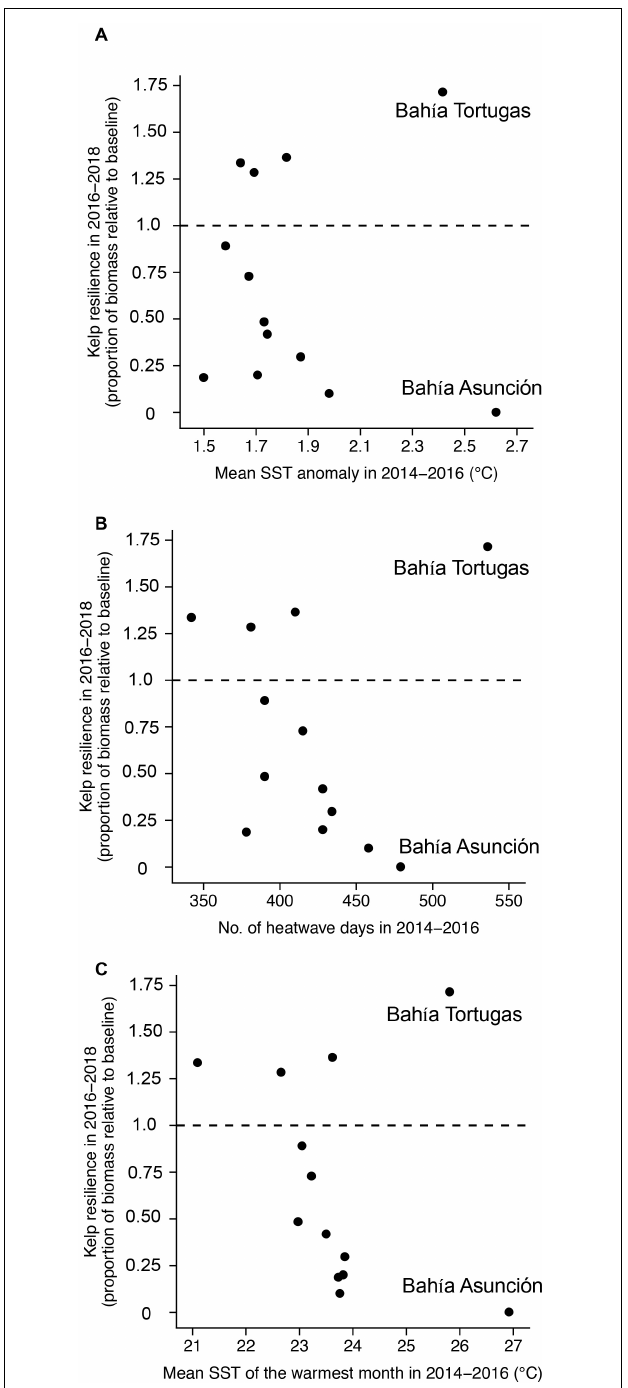
FIGURE 8 | Relationship between giant kelp resilience and 2014–2016 sea surface temperature metrics: (A) SST anomaly, (B) number of heatwave days, and (C) mean SST of the warmest month.